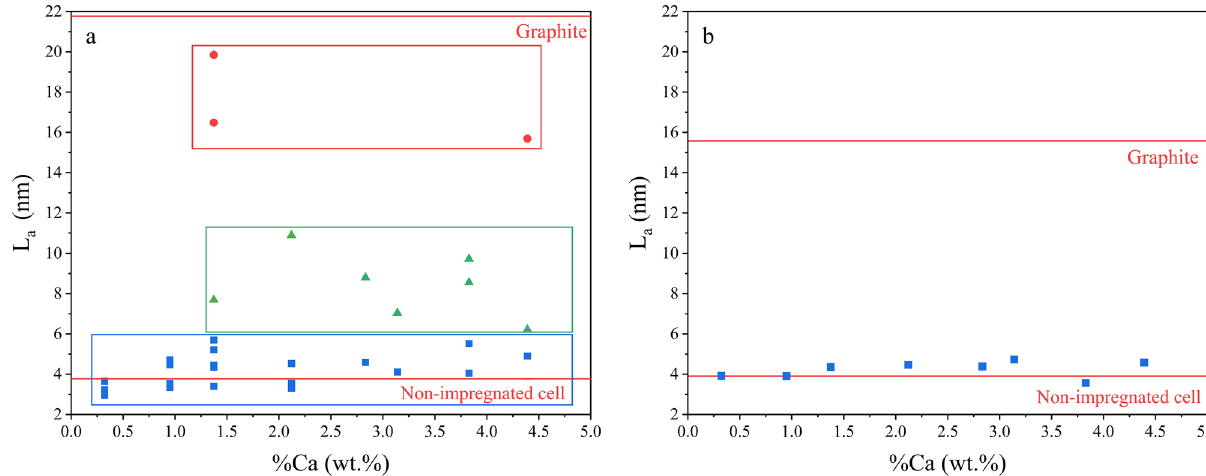
Figure 4. L a as a function of %Ca from ( a ) Raman spectroscopy and ( b ) XRD